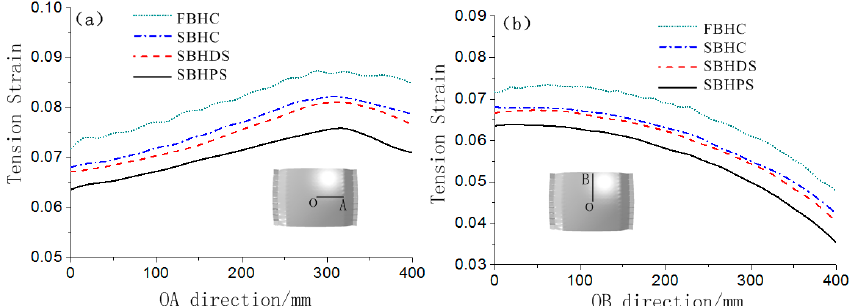
Figure 10. Tension strain distribution curves of the formed parts: ( a ) along OA direction; ( b ) along OB direction.